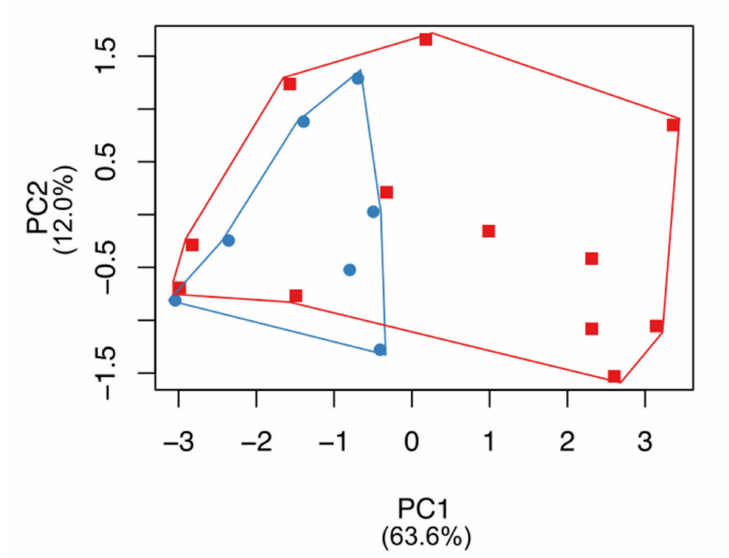
Figure 4. Morphometric comparison (principal component analysis performed on nine cranial measurements) among pygmy loris specimens representing northern (blue circle) and southern (red square) lineages. A projection of specimen scores for the first and second principal components is shown, with variance explained by each component (the third and fourth principal components are shown in Figure S7, and underlying statistics are provided in Table S2).